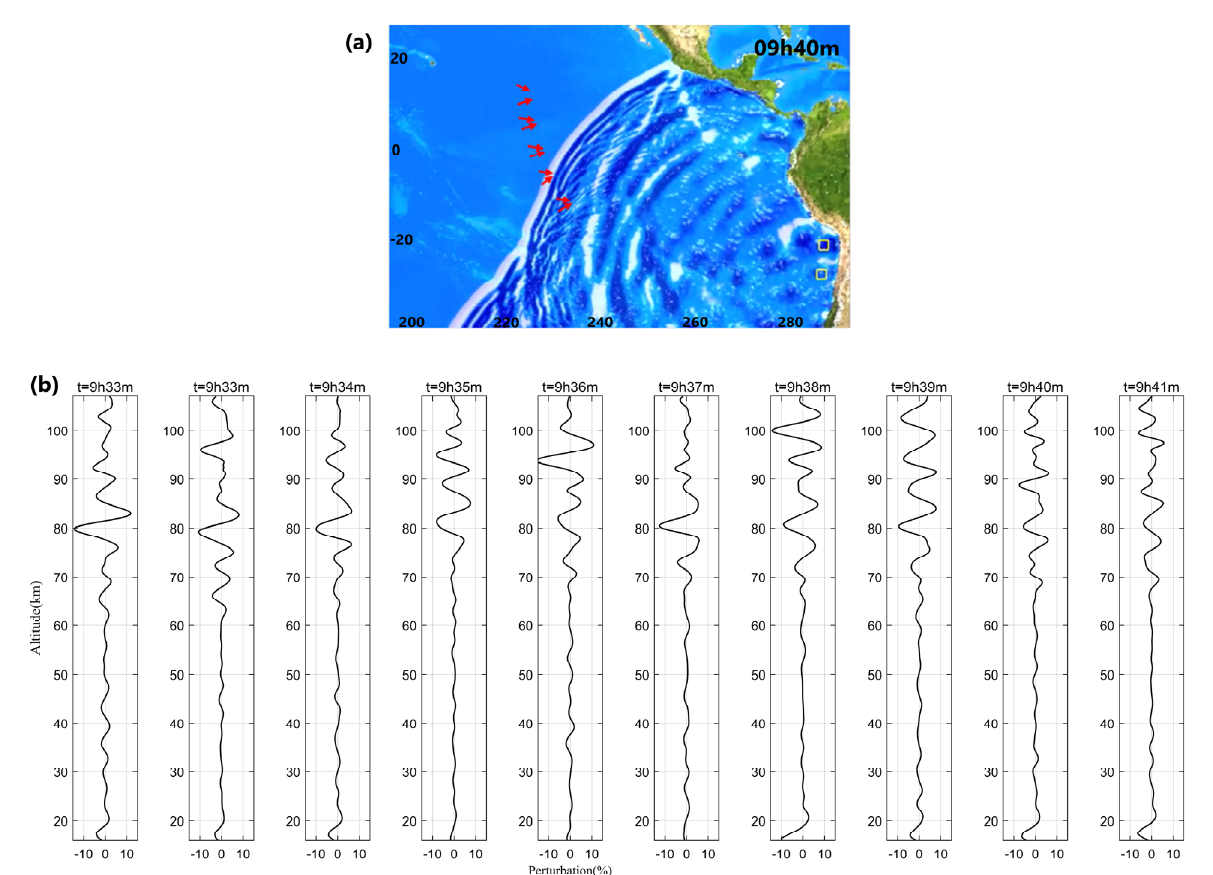
Figure 13. ( a ) The tsunami waves (http://nctr.pmel.noaa.gov/chile20150916/(accessed on 1 July 2022)) at 09h40m, the red arrows represent the projections of the tangent point of ten observations by SABER around the above moment. ( b ) Panels from left to right correspond to the temperature perturbations of the ten observations from top to bottom in ( a ), respectively.